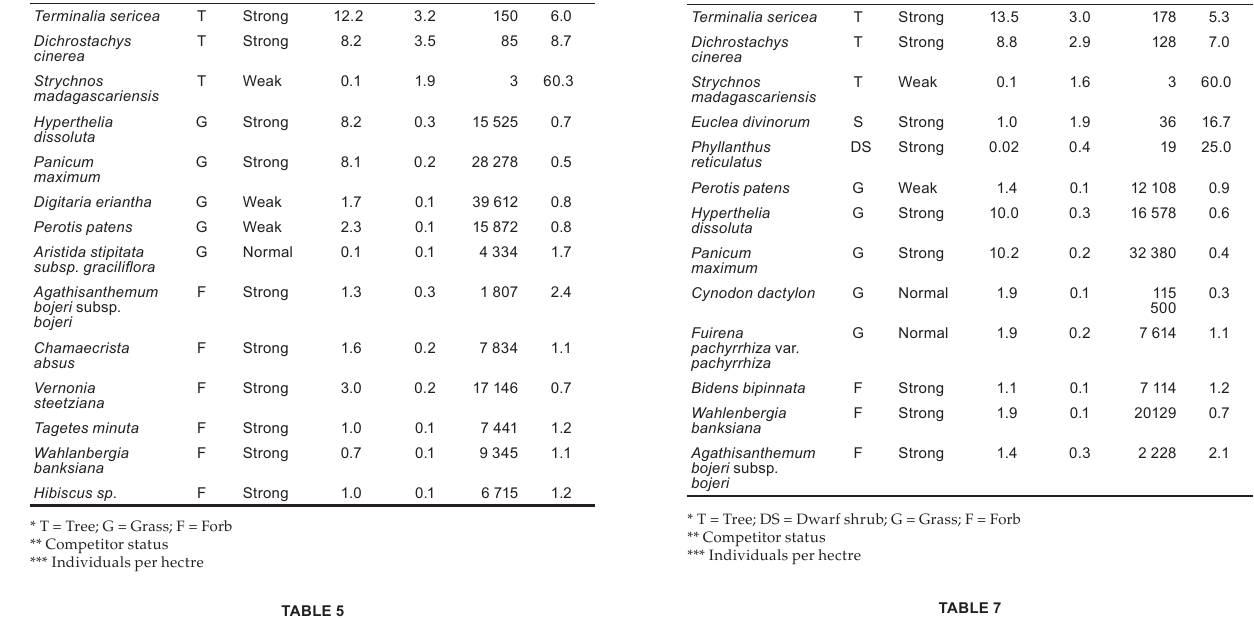
table 5 Species and growth form relations in Variant 1a